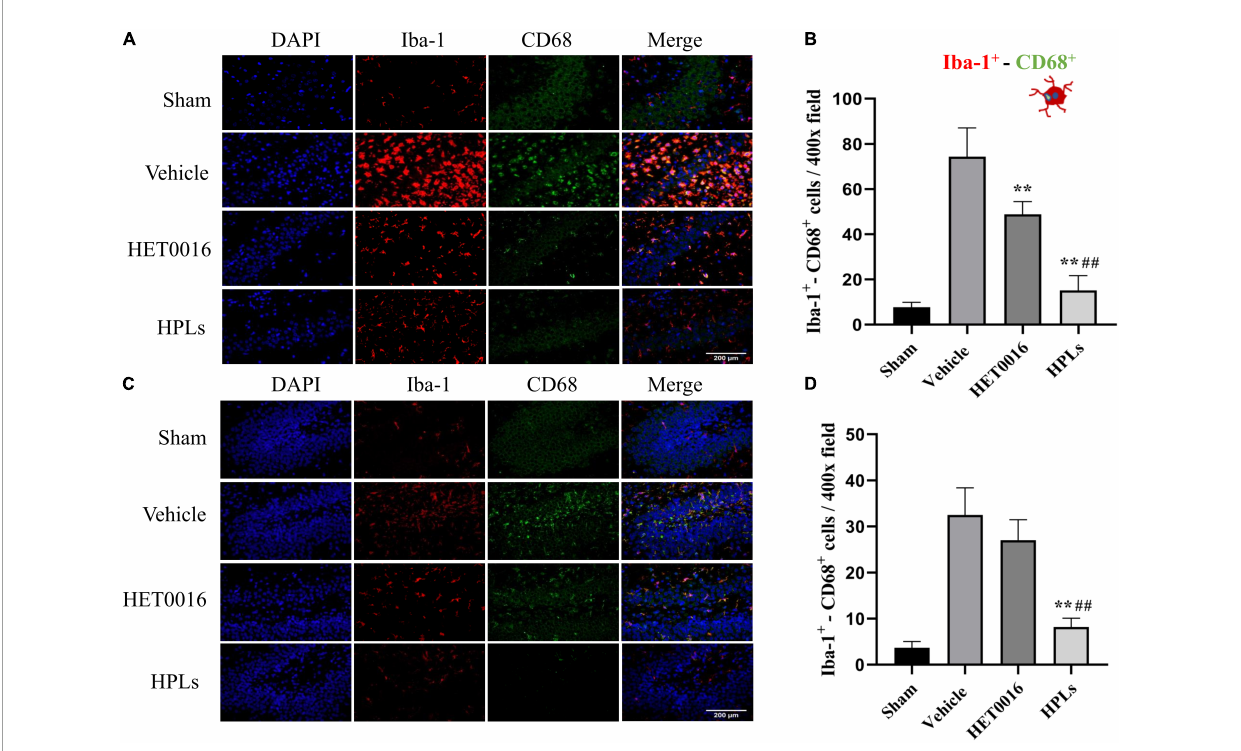
FIGURE6 HPLs reduced microglial activation after TBI. The Iba-1 + - CD68 + stain in the injured cortical (A) area and hippocampus (C) of the injured side. The green fluorescence represents the CD 68-positive cells, the red fluorescence represents the Iba-1 cells, and the blue fluorescence represents DAPI (magnification of region: 400 times). (B) The quantitative analysis of the Iba-1 + - CD68 + positive cells in groups (in the injured cortical area). (D) The quantitative analysis of the Iba-1 + - CD68 + positive cells in groups (hippocampus of the injured side). Values were mean ± SD. ** p < 0.01 versus Vehicle, ## p < 0.01 versus HET0016, n = 6 in each